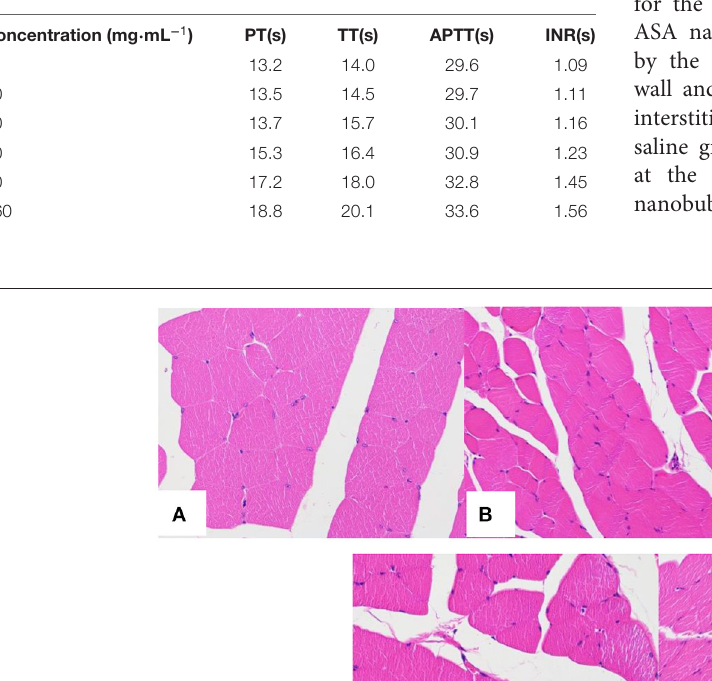
Frontiers in Medicine |